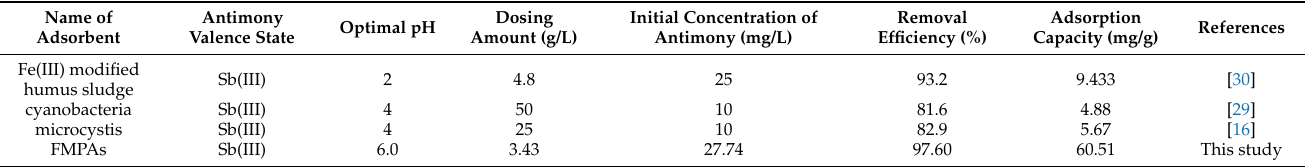
Table 5. Comparison of Sb removal of adsorbent materials.